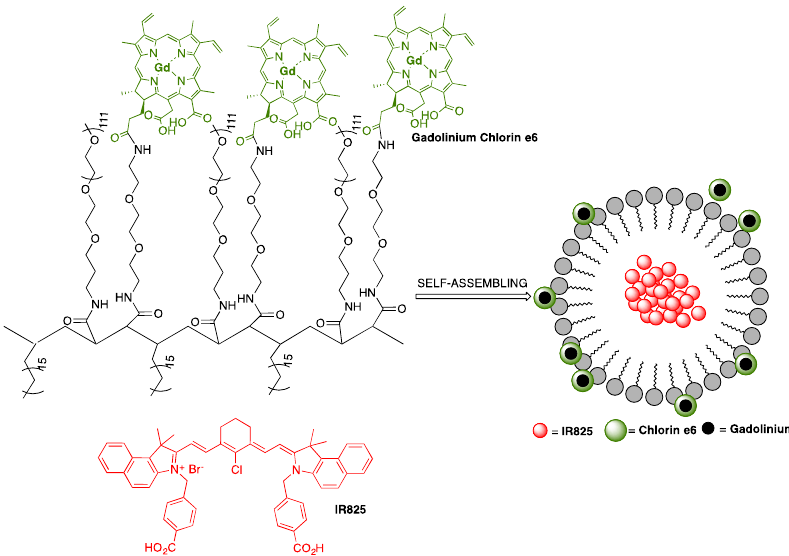
Figure 11. Schematic illustration of IR825@C18PMH-PEG-Ce6-Gd nanomicelles; Ce6 is attached on the backbone of C18PMH-PEG polymer via a short PEG linker; Gd 3+ forms a chelate complex with Ce6; IR825 is encapsulated inside the formed micellar system. IR825 is encapsulated inside the formed micellar